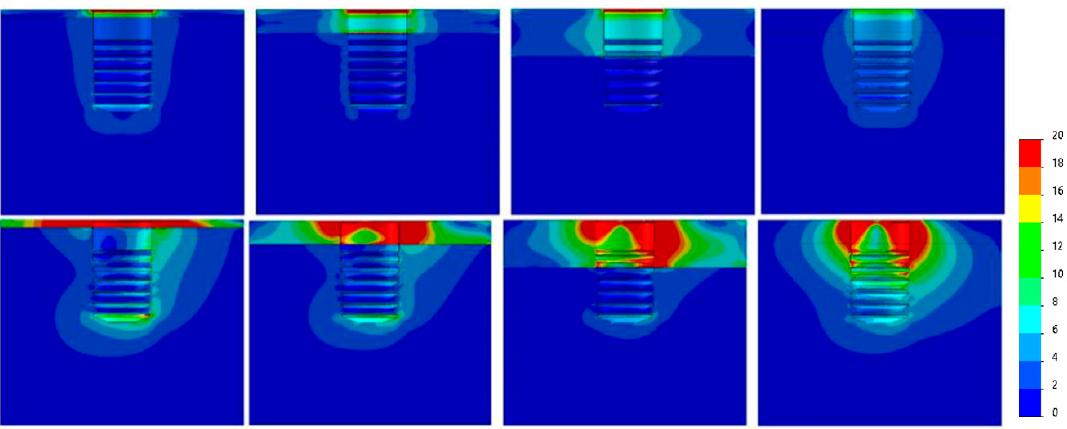
Figure 9. Von Mises equivalent stress (MPa) for Ø3.75 implant cases. Above, axial load, below, angled load. From left to right, Type IV, III, II, 0-I bone.